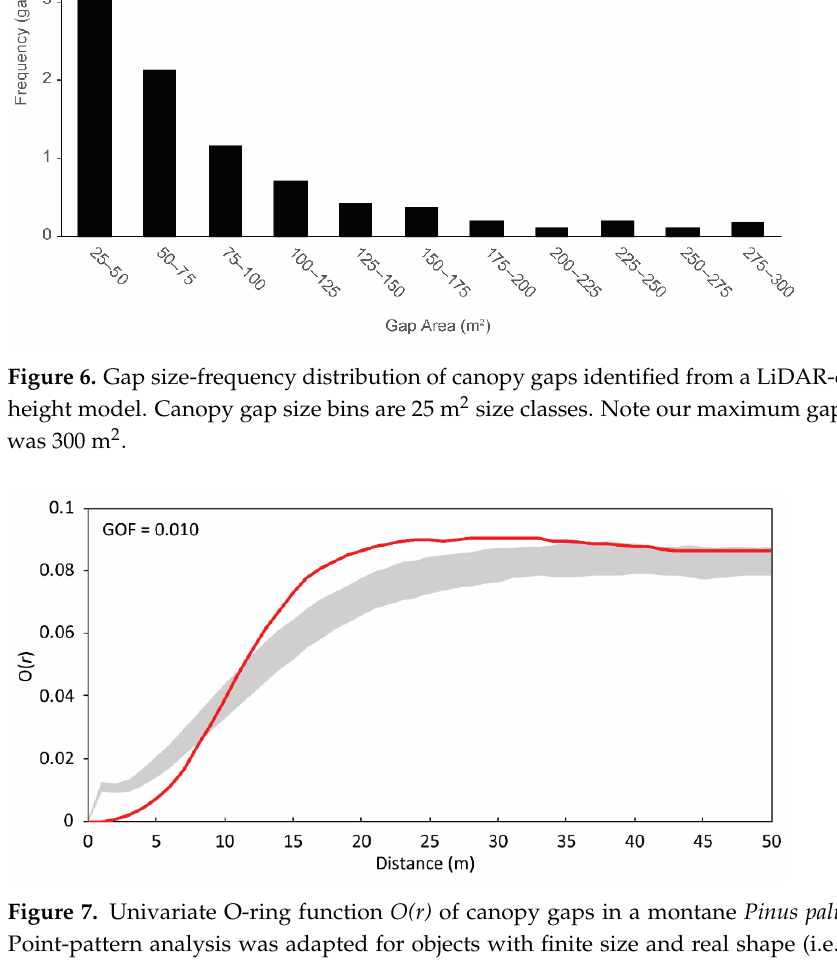
Figure 7. Univariate O-ring function O(r) of canopy gaps in a montane Pinus palutris woodland. Point-pattern analysis was adapted for objects with finite size and real shape (i.e., canopy gaps). Shaded areas represent a 95% confidence envelope simulated 99 times under the assumption of complete spatial randomness (CSR). The red line is observed values. Values above the gray shaded area indicate significant ( p < 0.05) clustering (i.e., gaps were closer in space than expected when compared to gap locations simulated under the assumption of CSR), and values below the shaded area represent significant dispersion of gaps. Goodness-of-fit (GOF) is reported in the top left.